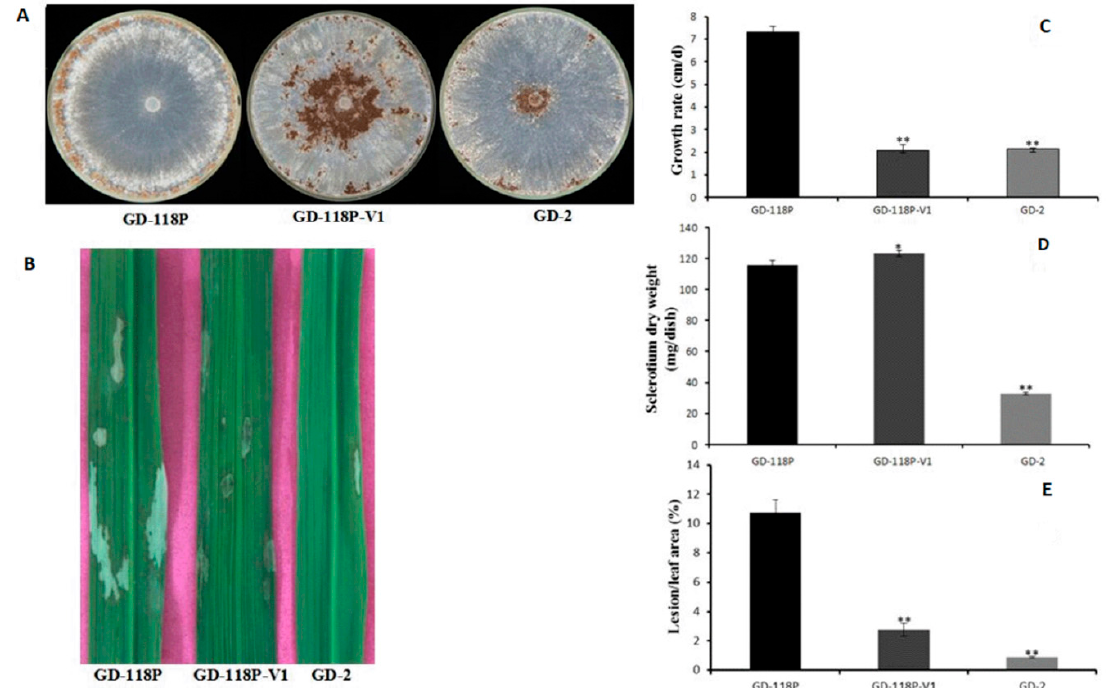
Figure 5. Hypovirulence-associated traits in strain GD-118P-V1 of Rhizoctonai solani AG-1 IA. (A) Colony morphology. Culture characteristics of strains GD-118P, GD-118P-V1, and GD-2 on PDA plates at 28 ◦ C for seven days. (B) Pathogenicity. The symptoms on detached rice leaves caused by isogenic strains GD-118P and GD-118P-V1, and GD-2 incubated at 28 ◦ C for 72 h. (C and D) Comparison of average mycelial growth rate and sclerotia dry weight on PDA plates of the strains GD-118P, GD-118P-V1, and GD-2. (E) Average lesion areas caused by the strains GD-118P, GD-118P-V1, and GD-2 on detached rice leaves. In (C), (D), and (E), the data were indicated as arithmetic means ± standard error, and significant differences were assessed using the Student t test. Single asterisk (*) indicates p < 0.05, and double asterisks (**) indicate p < 0.01.